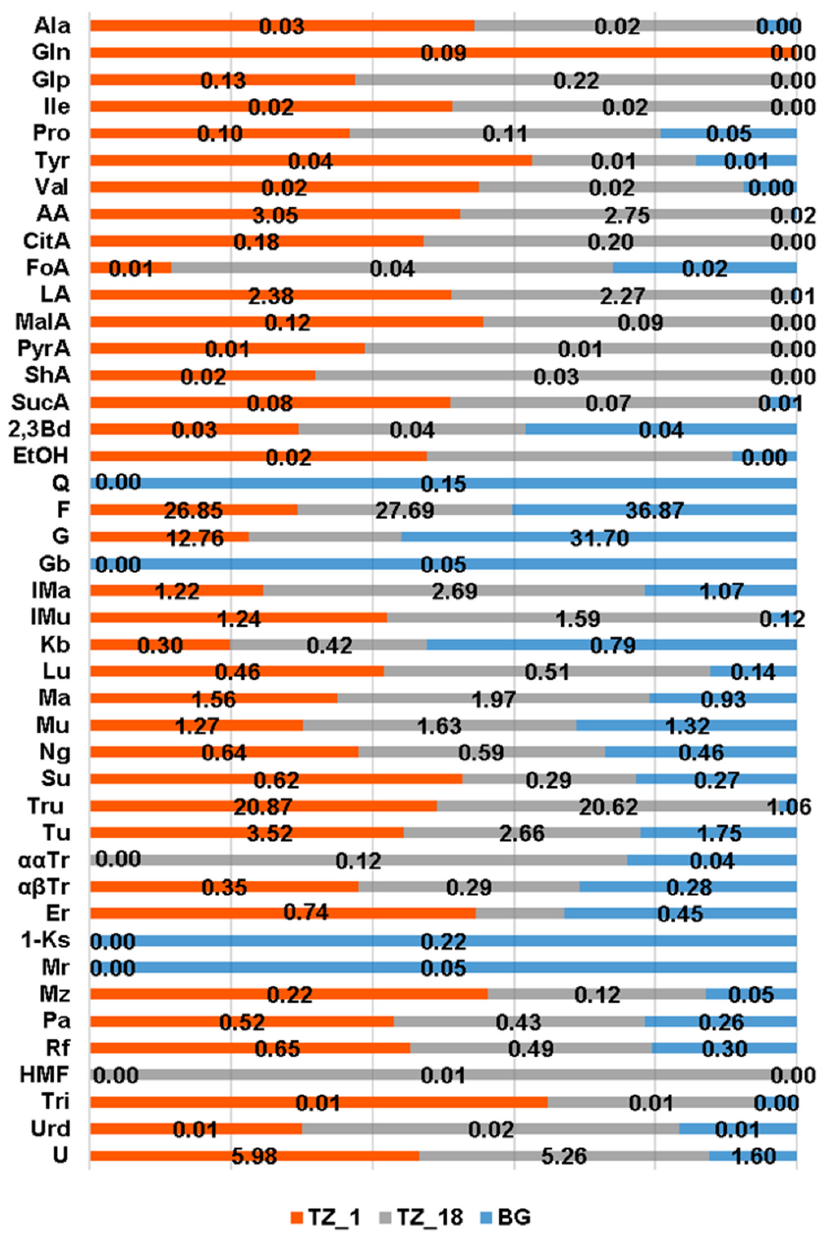
Figure 1. Quantities of honey components (in g/100 g) in M. ferruginea honey (TZ_1), M. ferruginea honey after 18 months of storage (TZ_18), and Bulgarian honey (BG) (average values of 10